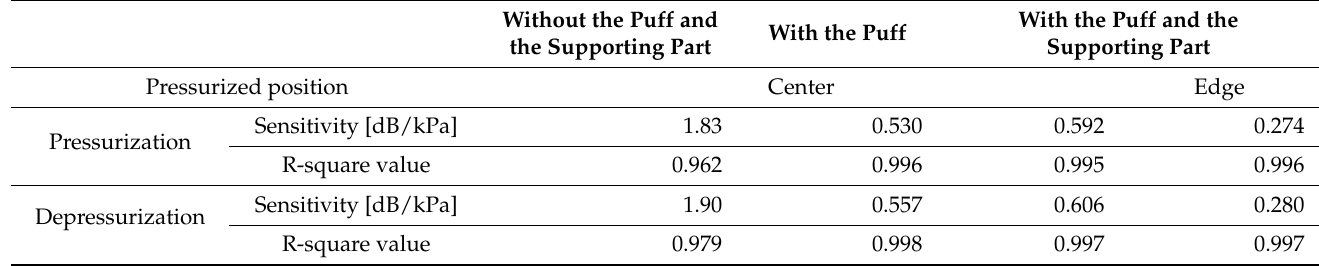
Table 1. Sensitivities and R-square values of the sensor under each condition.